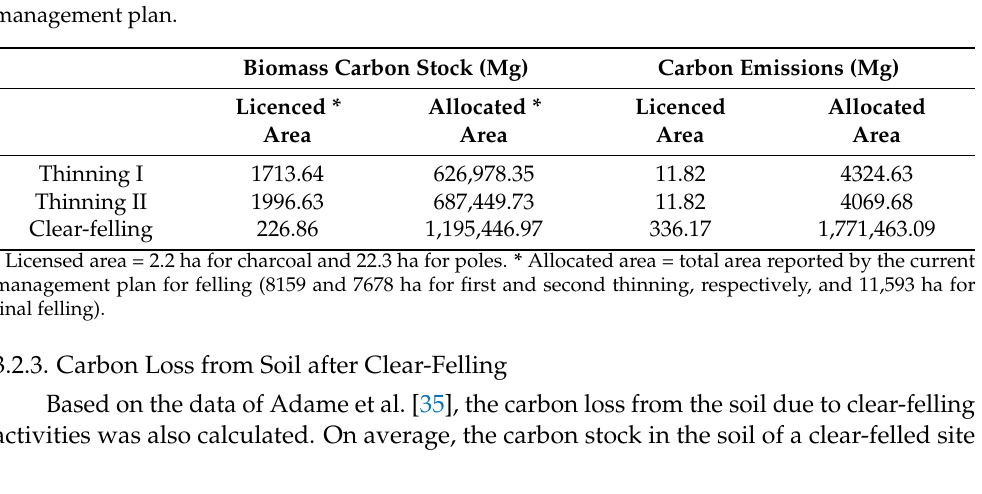
Figure 4. ( A ) Mangrove charcoal and, ( B ) pole production activities with their carbon emission values (Mg C) at Matang Mangrove Forest Reserve (tables). The emissions were calculated based on the licenced area assigned to one contractor. Continued arrows show direct activities, while discontinued show indirect activities in each production system. Carbon sources are numbered in order of occurrence (adapted from Satyanarayana et al. [27]). Table 4. Comparison between carbon stock in the vegetation biomass and carbon emissions over a period of 30 years for the productive forest in the MMFR. For the carbon stock, the values were calculated based on 15-, 20- and 30-year-old forest stands AGB values (163.5 Mg ha − 1 , 190.5 Mg ha − 1 , 219.4 Mg ha − 1 , respectively) following the age of thinning and clear-felling reported by the last management plan.